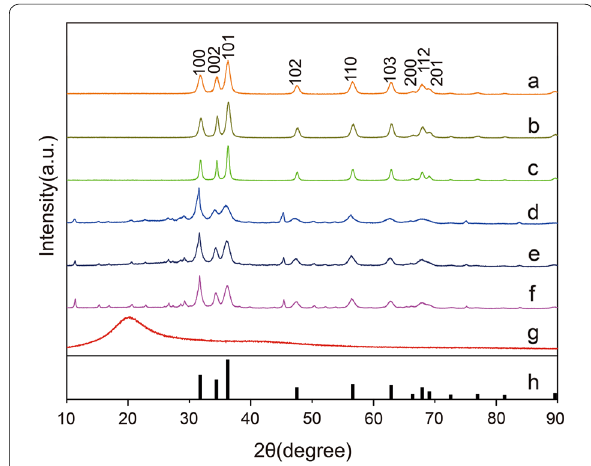
Fig. 5 The XRD patterns of ZnO and lipid-coated ZnO NPs of